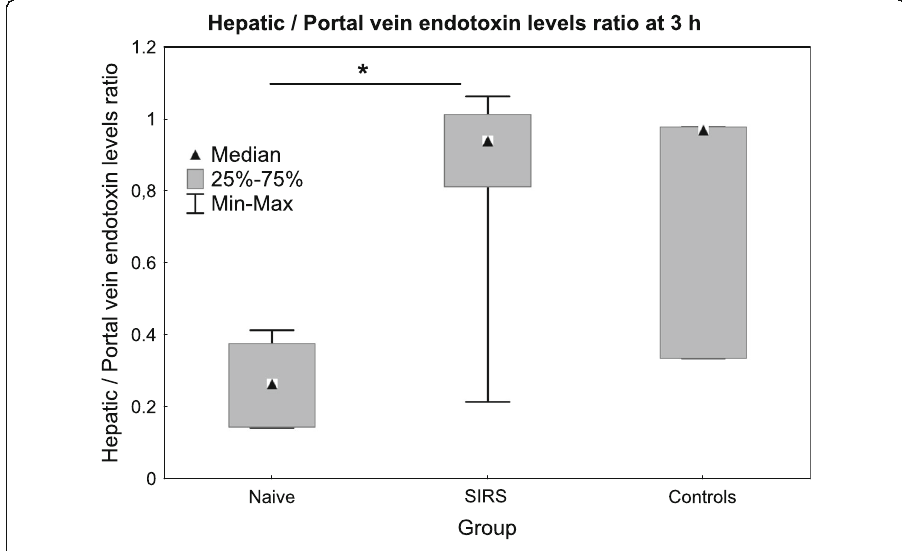
Fig. 3 The hepatic to portal venous endotoxin ratio during the E. coli infusion at 3 h. Values are expressed as median (IQR). *** p < 0.001. Difference between the SIRS and naive group as assessed with the